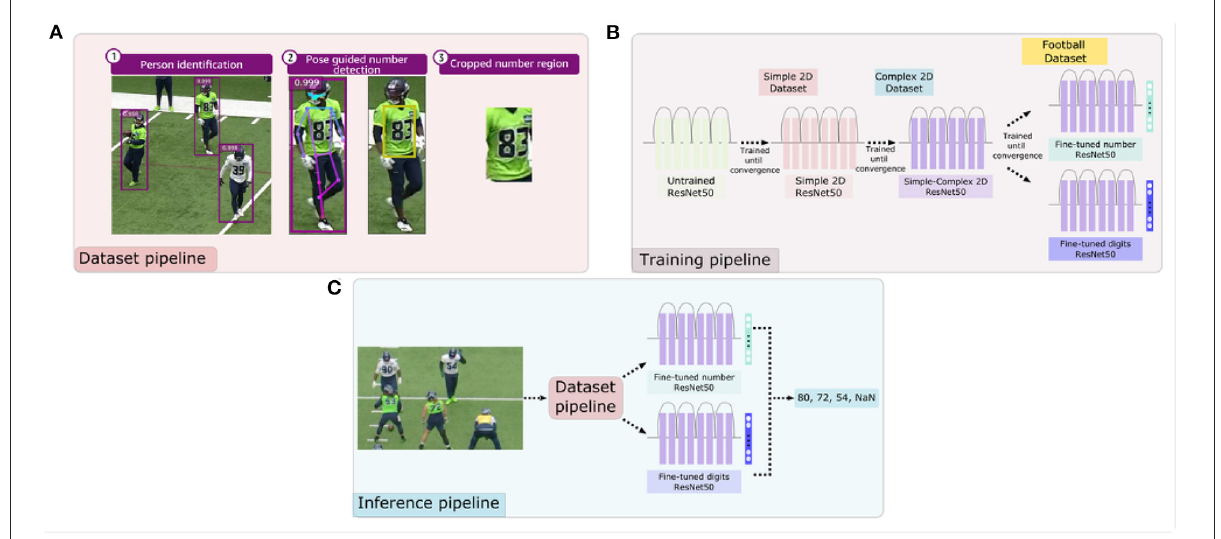
FIGURE7 Overview of the approach for extracting data, training, and generating jersey number predictions. Panel (A) describes the high-level football dataset processing pipeline—identify person in video, pass each person image through the pose estimation model to identify the torso region and crop them. Panel (B) shows the sequential pre-training of multi-class/label models with synthetic number datasets—Simple2D and Complex2D as well as fine-tuning on football dataset. Panel (C) represents the inference pipeline that uses data pipeline from (A) to crop jersey numbers and perform prediction using multi-class/label models (B)